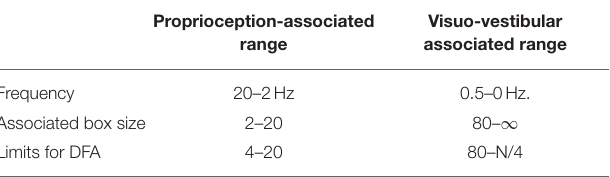
TABLE 1 | Frequency ranges for using DFA on specific control loops of